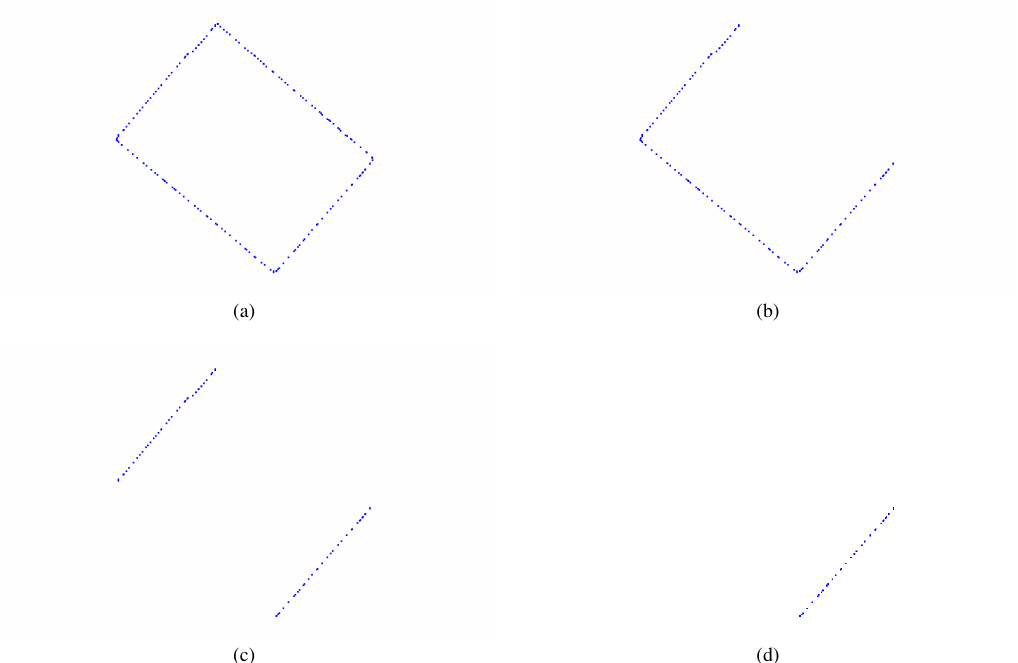
Figure 15: The RANSAC input in the four iterations needed to identify the four sides of the considered